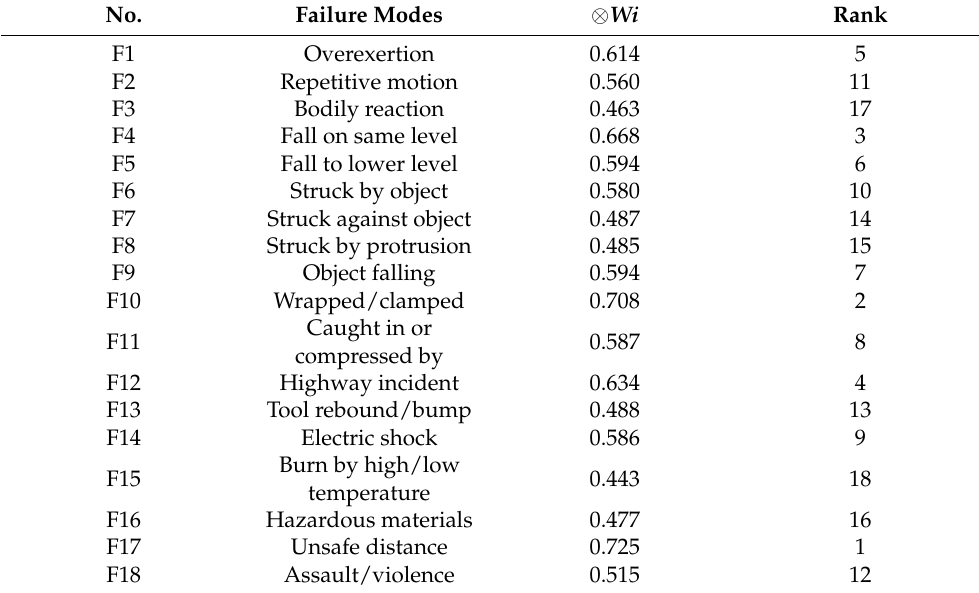
Table 9. Results of the GRA method for ranking 18 failure